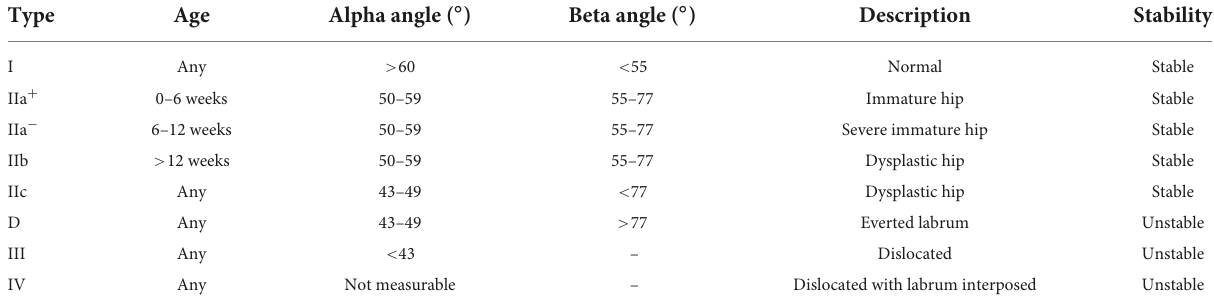
TABLE 1 The Graf classification system of developmental dysplasia of the hip (19).